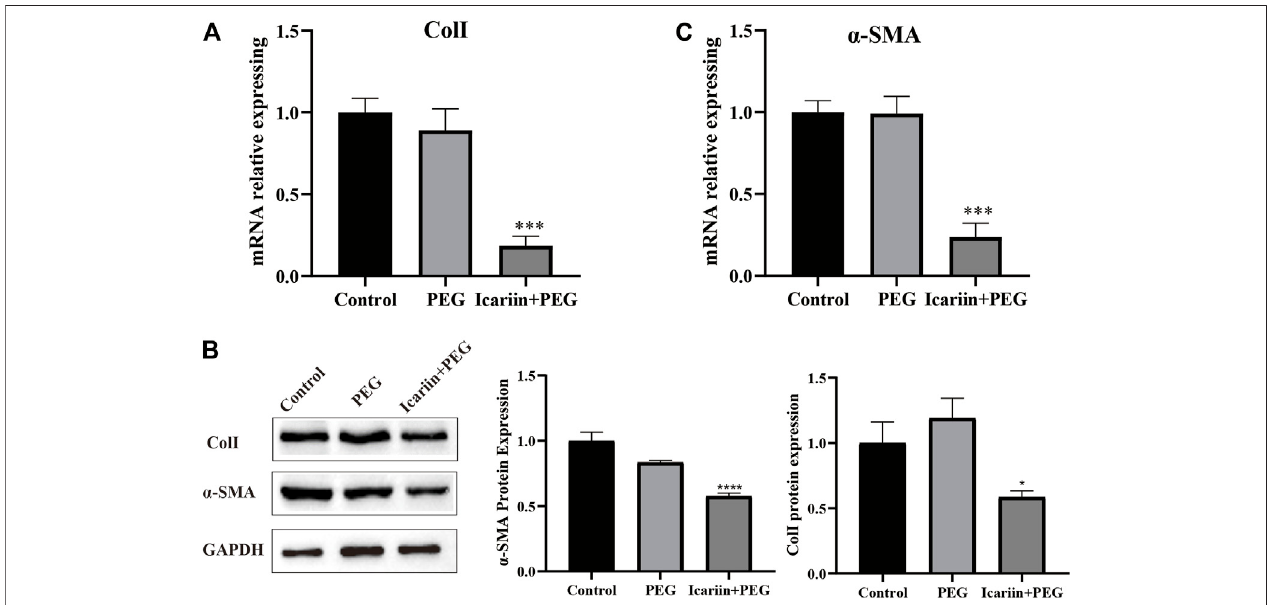
FIGURE3| Icariin+PEGhydrogelalleviatedskin fi brosis. (A) RT-PCRanalysisofCol Ⅰ expressioninthreegroups. (B) ProteinexpressionlevelofCol Ⅰ and α -SMAas detectedbywesternblottingonday14 attheinjuredsites.Quanti fi cationofthewesternblottingbandscomparedtothatofthecontrolgroup. (C) RT-PCRanalysisof α - SMA expression in three